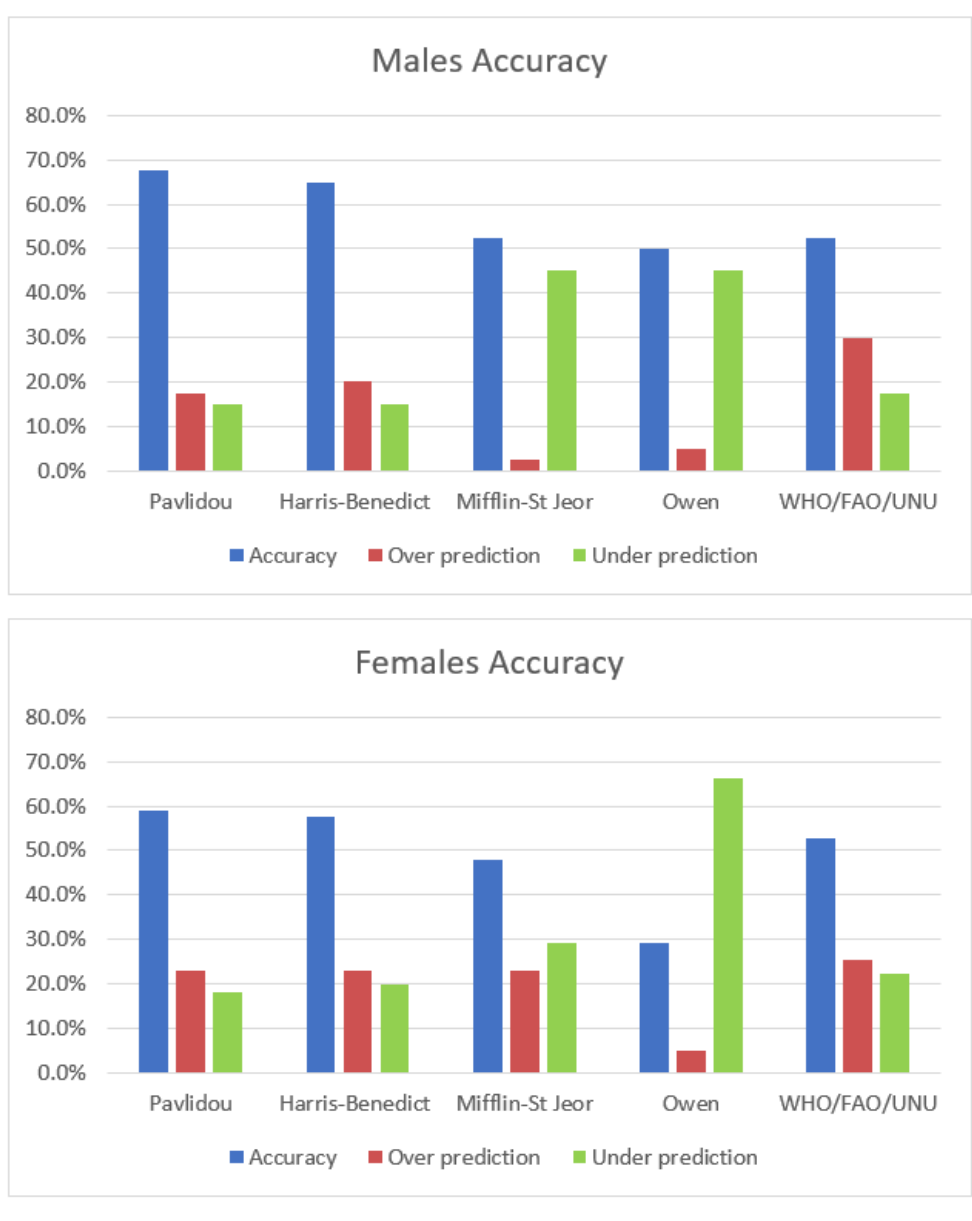
Figure 1. Prediction accuracy within ±10%. Accuracy of prediction equations for measurements of resting metabolic rate within ±10% using each equation in 40 men and 127 women, respectively.